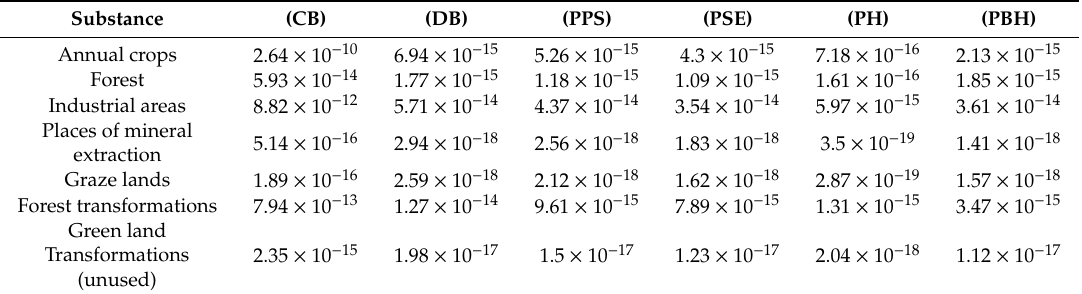
Table 10. Results of environmental impact characterizing for the category of land use